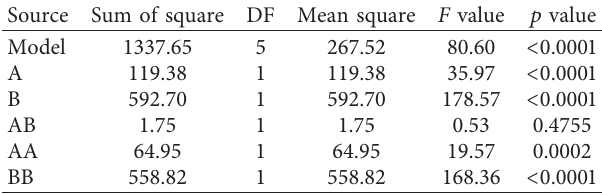
Table 3: Results of regression analysis